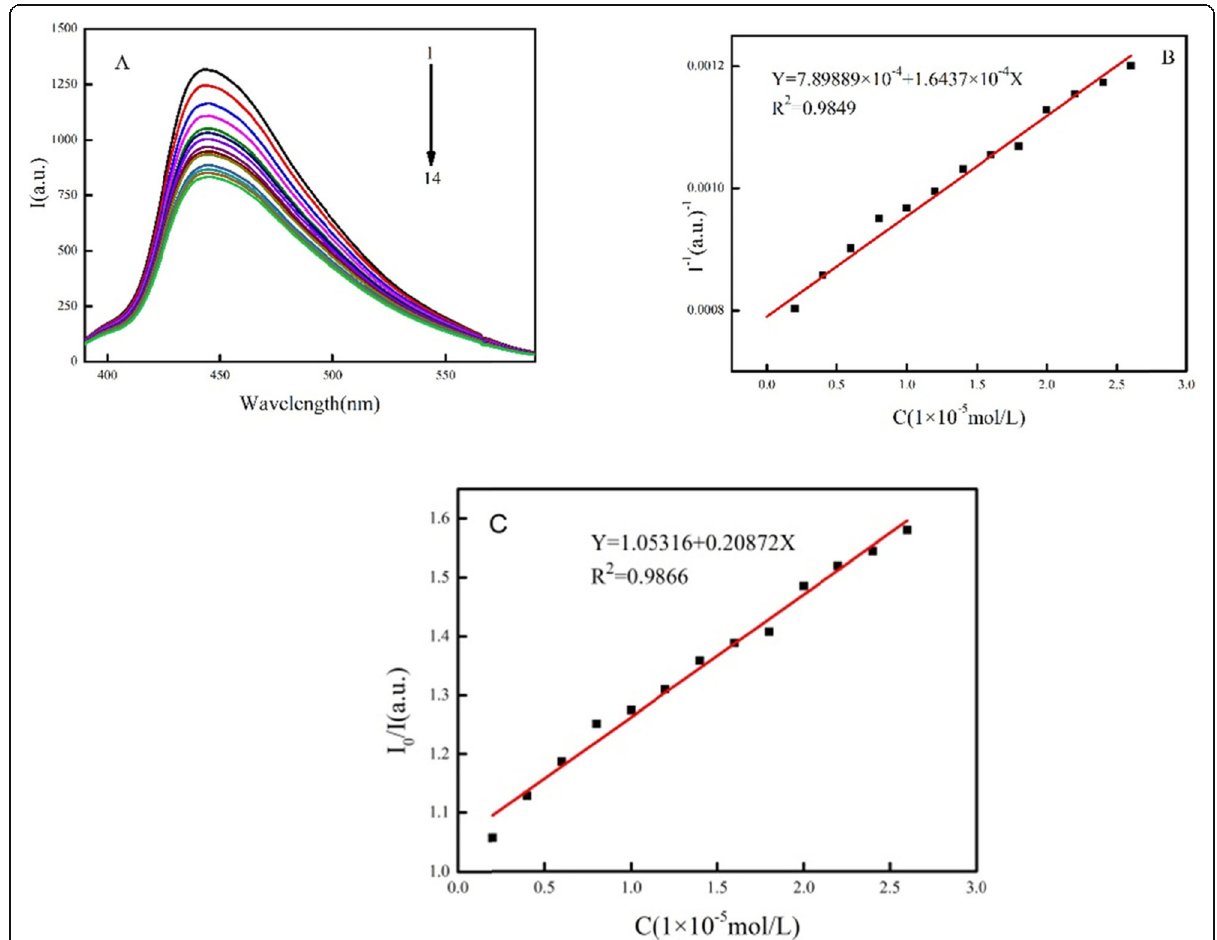
Fig. 6 The fluorescence properties of complex quenched MNZ (C metronidazole : 0; 0.2 × 10 − 5 mol/L; 0.4 × 10 − 5 mol/L; 0.6 × 10 − 5 mol/L; 0.8 × 10 − 5 mol/L; 1 × 10 − 5 mol/L; 1.2 × 10 − 5 mol/L; 1.4 × 10 − 5 mol/L; 1.6 × 10 − 5 mol/L; 1.8 × 10 − 5 mol/L; 2 × 10 − 5 mol/L; 2.2 × 10 − 5 mol/L; 2.4 × 10 − 5 mol/L; 2.6 × 10 − 5